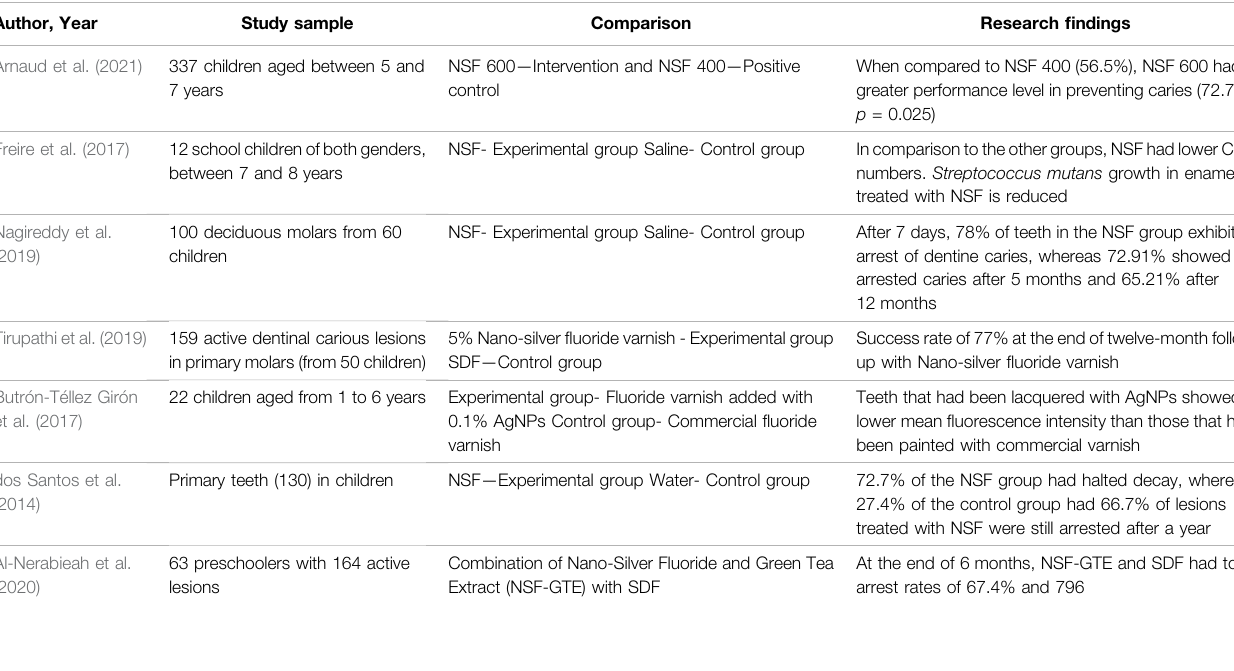
TABLE 3 | In-Vivo randomized controlled studies related to NSF for caries